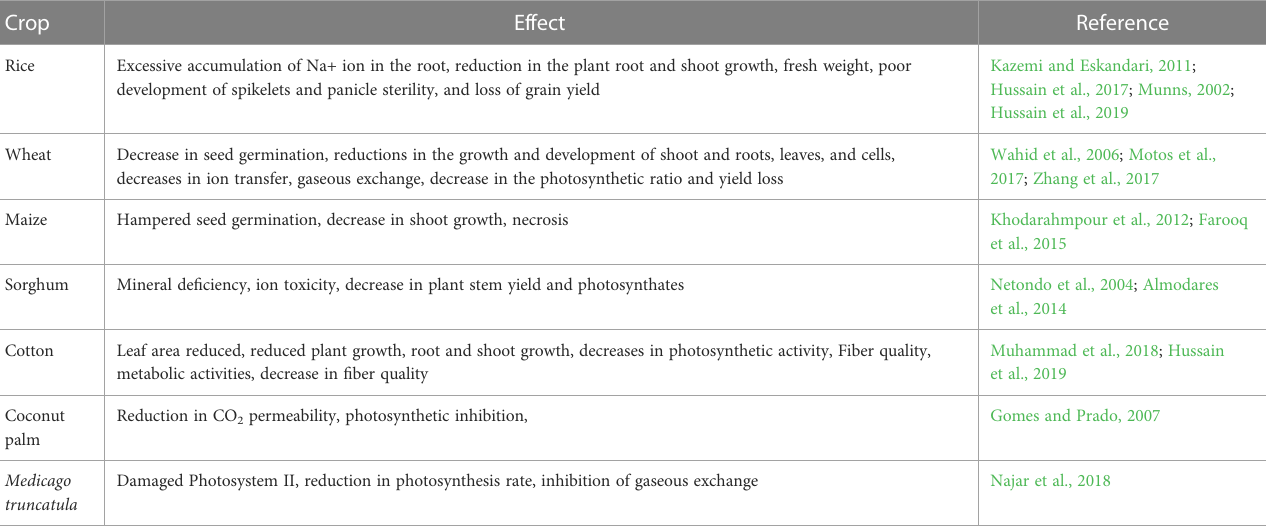
TABLE 3 Impacts of salinity stress on some major crops.